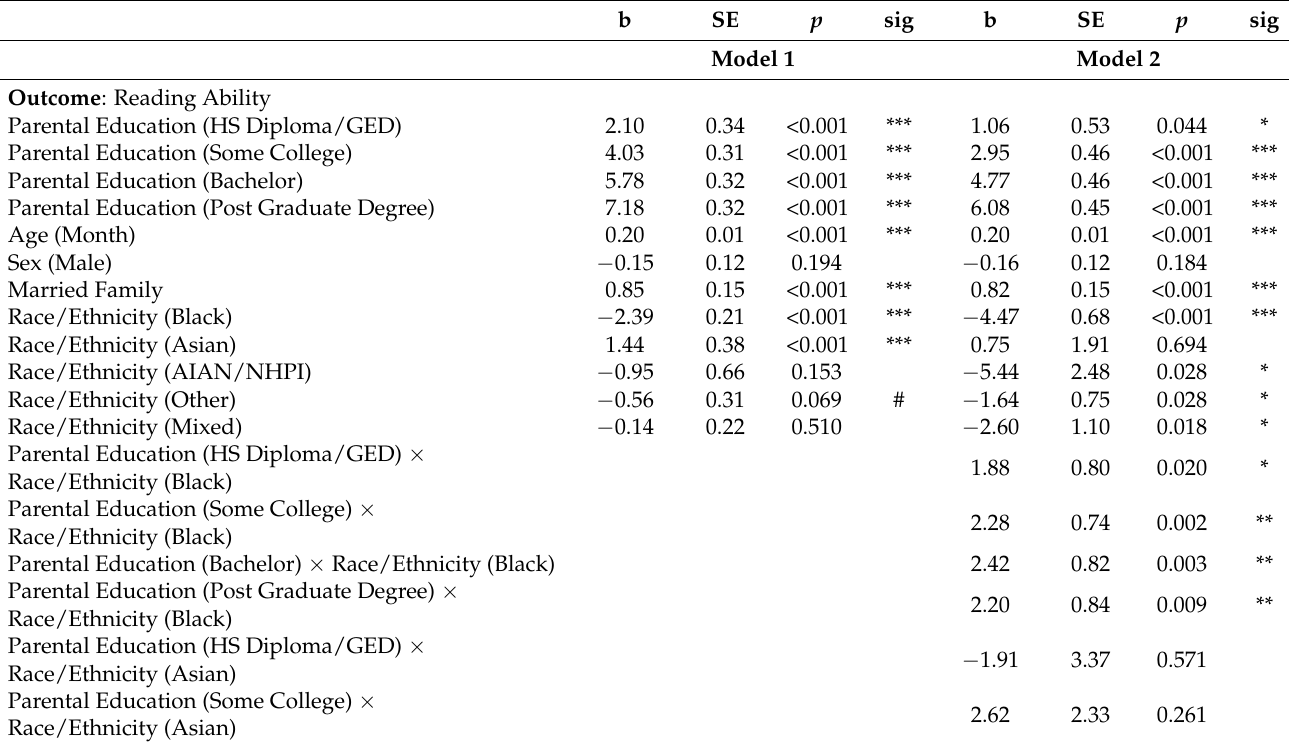
Table 7. Summary of mixed-effects regression models on the association between parental education and reading